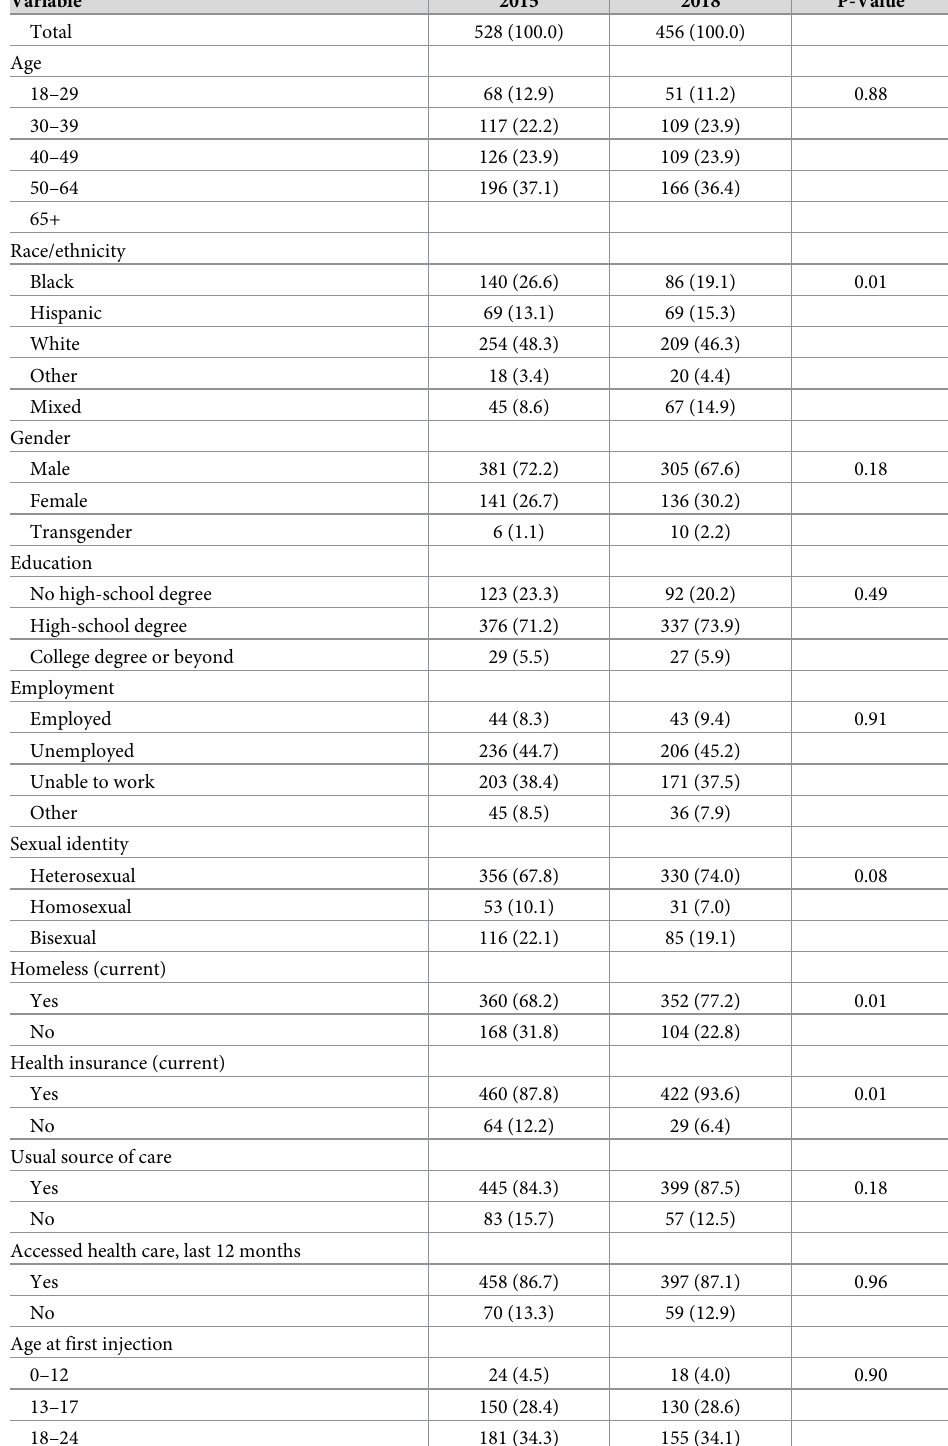
Table 1. Select characteristics of people who inject drugs participating in the 2015 and 2018 National HIV Behav- ioral Surveillance surveys, San